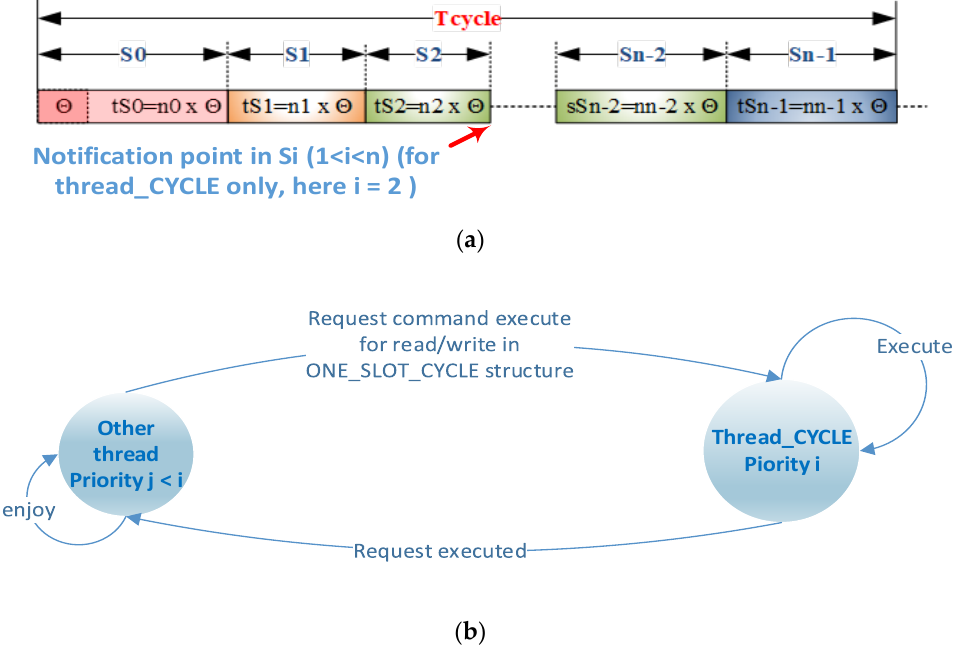
Figure 4. Slot notification point and a mutual exclusion method for ONE_SLOT_ENTRY. ( a ) Notification point at the end of the slot; ( b ) using flags, event, etc. to avoid race condition for access ONE_SLOT_ENTRY.